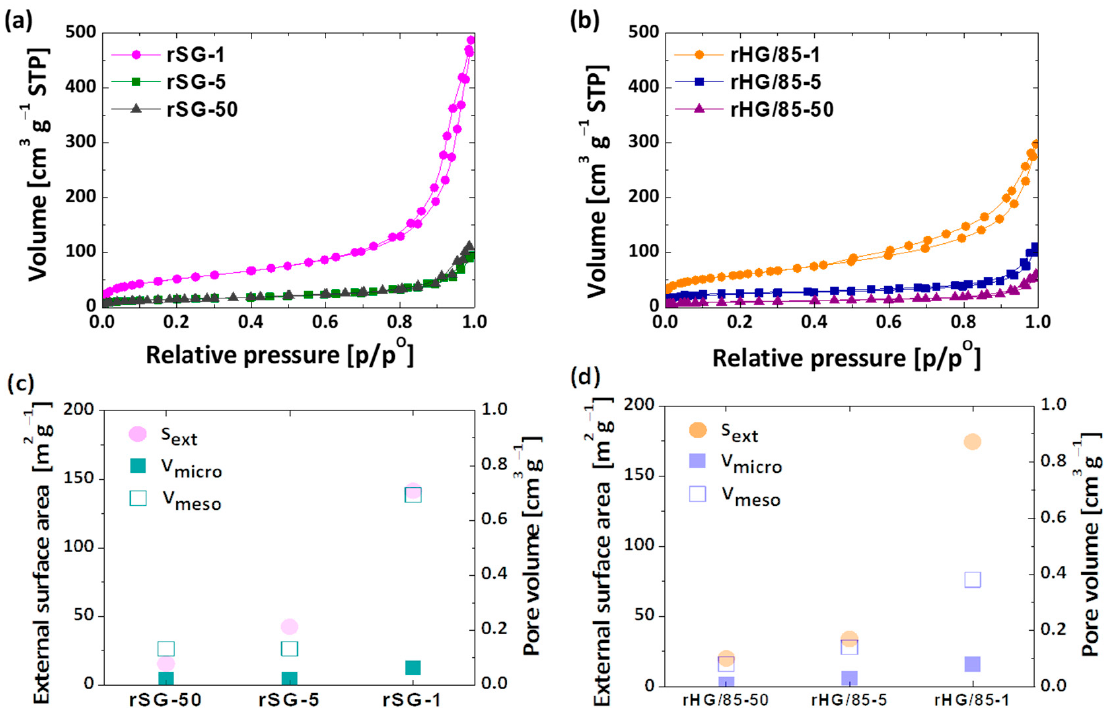
Figure 6. N 2 adsorption-desorption isotherms and textural properties of reduced silica ( a , c ) and C-Si hybrid gels ( b , d ) using different heating rates.